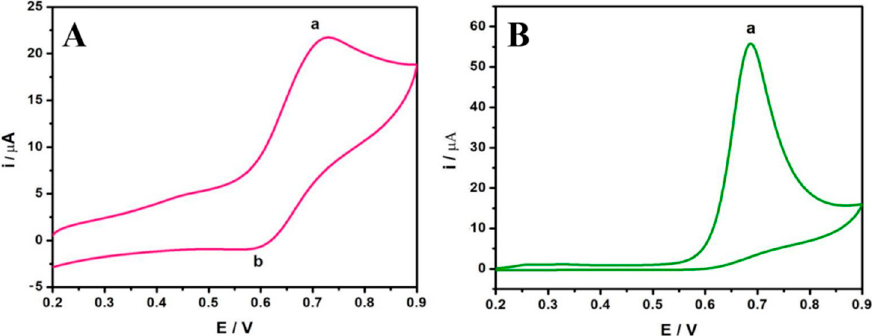
Figure 5. Cyclic voltammograms of 1 mM CPZ in 0.1 M PBS with ( A ) pH 4.5 and ( B ) pH 7.0. Nanomaterials 2020 , 10 , x 10 of 15